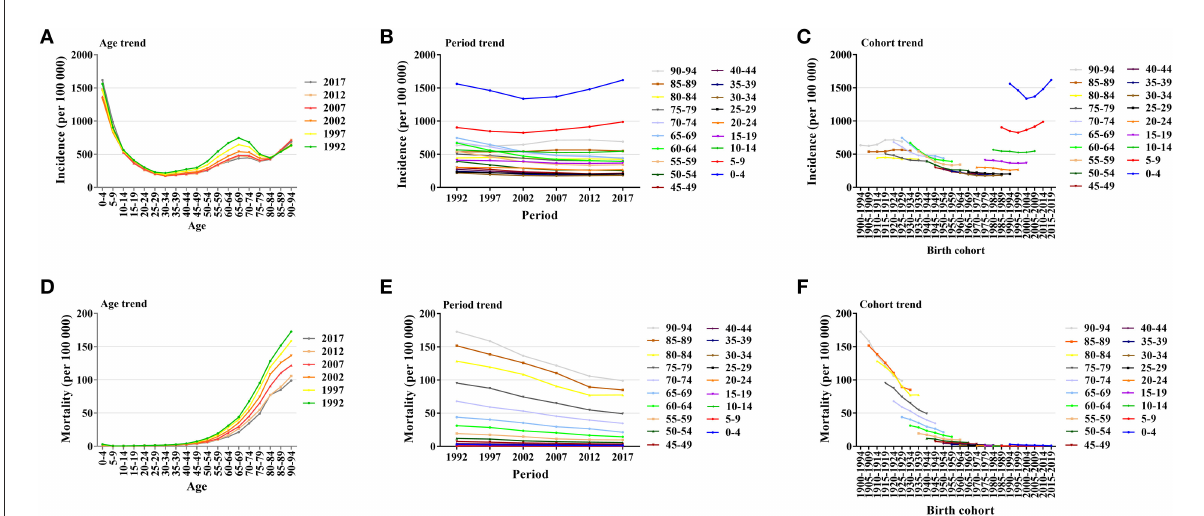
FIGURE5 Global trends in asthma incidence and mortality. (A) Global trends in asthma incidence by age. (B) Global trends in asthma incidence by period. (C) Global trends in asthma incidence by birth cohort. (D) Global trends in asthma mortality by age. (E) Global trends in asthma mortality by period. (F) Global trends in asthma mortality by birth cohort.